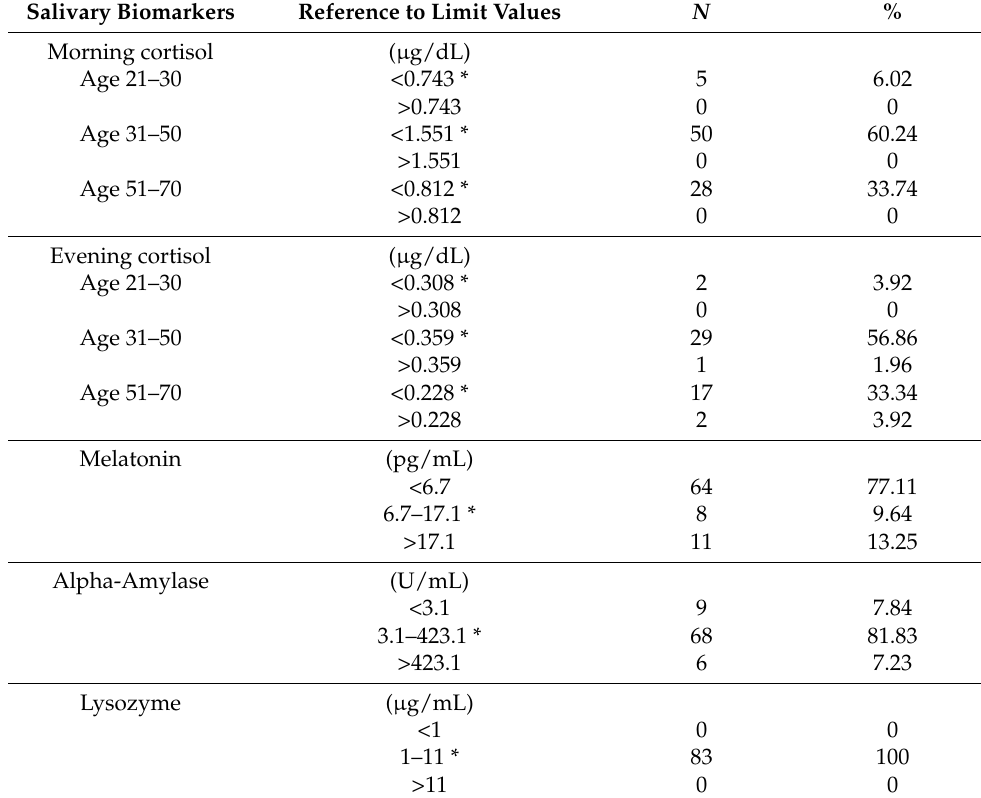
Table 4. Sample frequencies in salivary biomarkers range